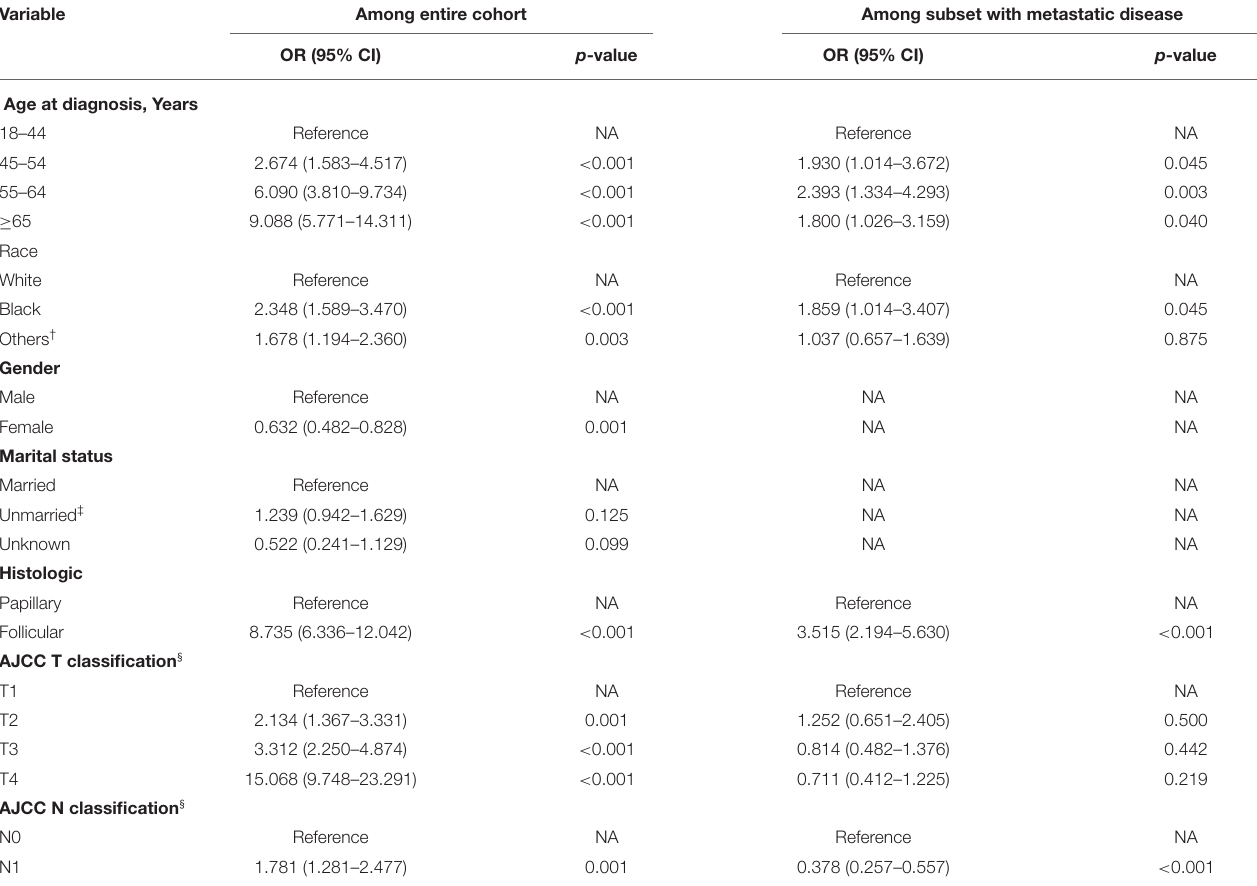
TABLE 2 | Multivariable logistic regression for developing SBM in DTC patients.